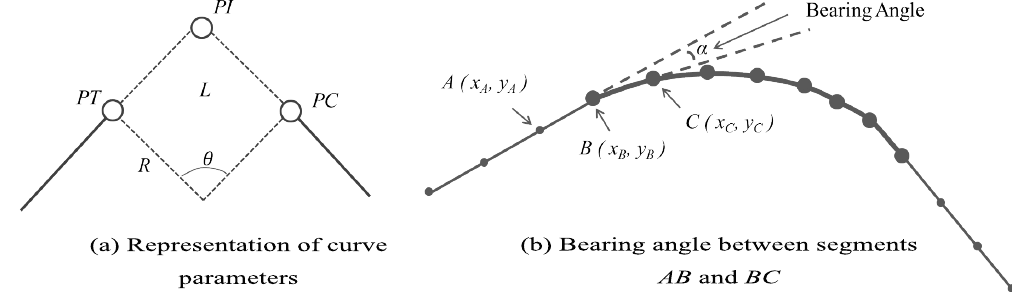
Figure 4. Curve parameters